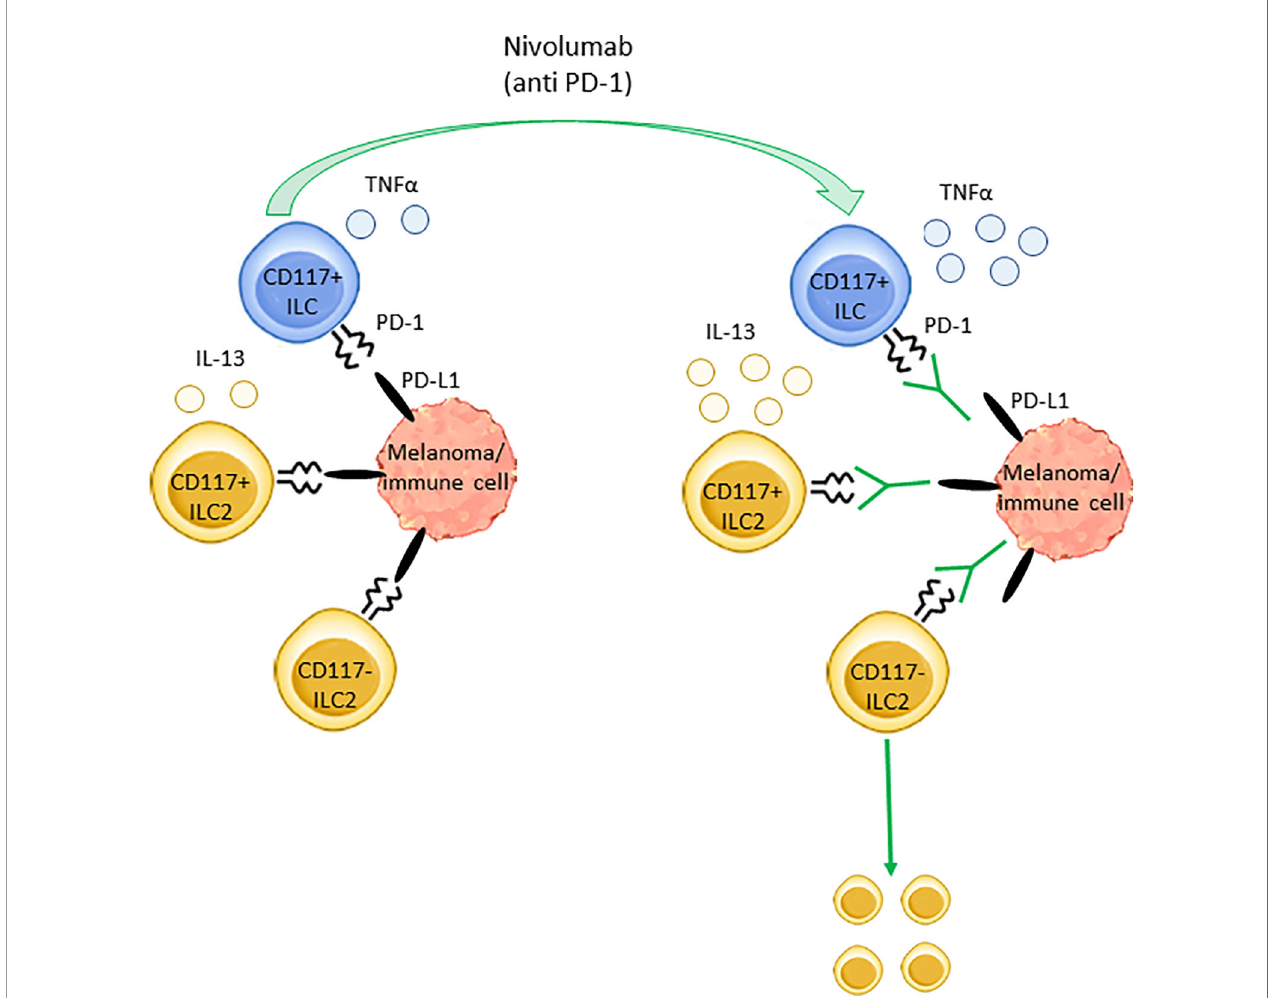
FIGURE 5 | Nivolumab effects on ILCs subsets in stage IV melanoma. The inhibitory receptor PD-1 regulates the secretory activity of both ILC2s and ILC3s as well as CD117 + ILC precursors. In stage IV melanoma patients, PD-1 targeting through Nivolumab enhances the production of TNF a and IL-13 from circulating CD117 + ILCs and CD117 + ILC2s, respectively. Furthermore, Nivolumab induces the expansion of blood CD117 - ILC2s. These effects are likely due to Nivolumab-mediated disruption of the interaction between PD-1, expressed on ILCs, and its ligand PD-L1, expressed on melanoma cells and/or other immune cells such as macrophages, MDSCs and